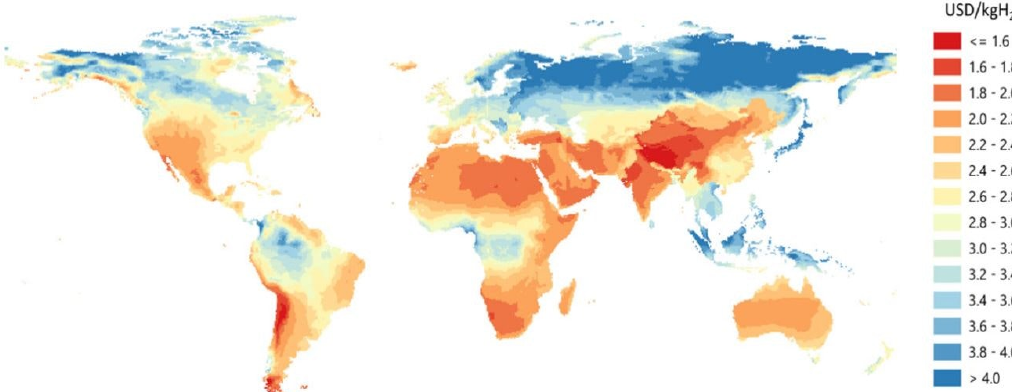
Figure 3. Long-Term economic H 2 production costs based on hybrid solar PV and onshore wind technologies in various geographical regions [25]. Capital expenses for the electrolyzer are assumed to be USD 450/kWe, the efficiency is assumed to be 74% (LHV). Capital expenses associated with solar PV and onshore wind vary within the range of USD 400–1000/kW and USD 900–2500/kW, respectively, depending on geographical region. The economic discount rate is assumed to be 8%. Refer to [25] for more details of the assumptions.